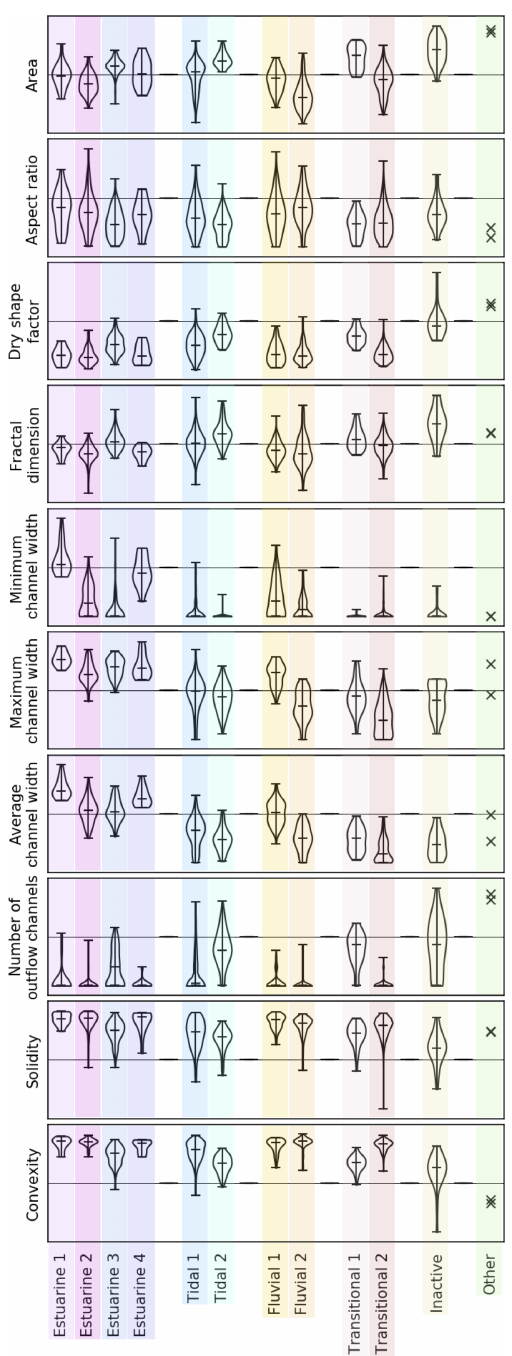
Figure 8. Violin plots of parameter values for each class. In addi- tion to the minimum, median, and maximum values of each metric, the full sample distribution is also shown for each of the six main classes or groups. For example, the number of outflow channels in the inactive class has a wide distribution, whereas convexity within the estuarine classes has a narrower distribution.